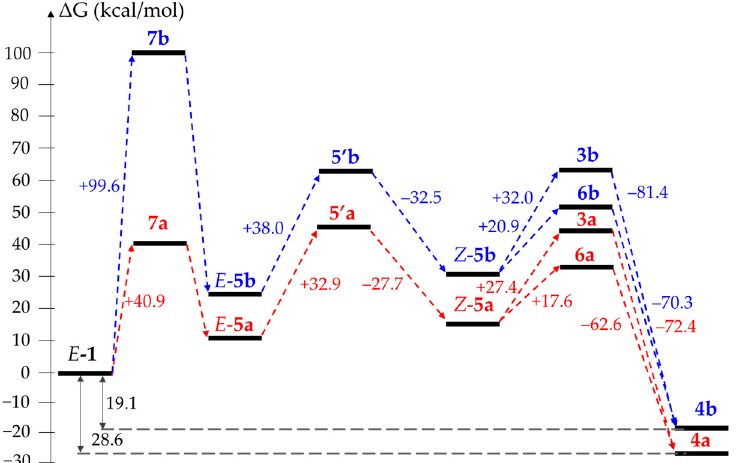
Figure 4. Comparison of reaction profiles for E - 1a → 4a (red) and E - 1b → 4b (blue) via “zwitterionic” path B.